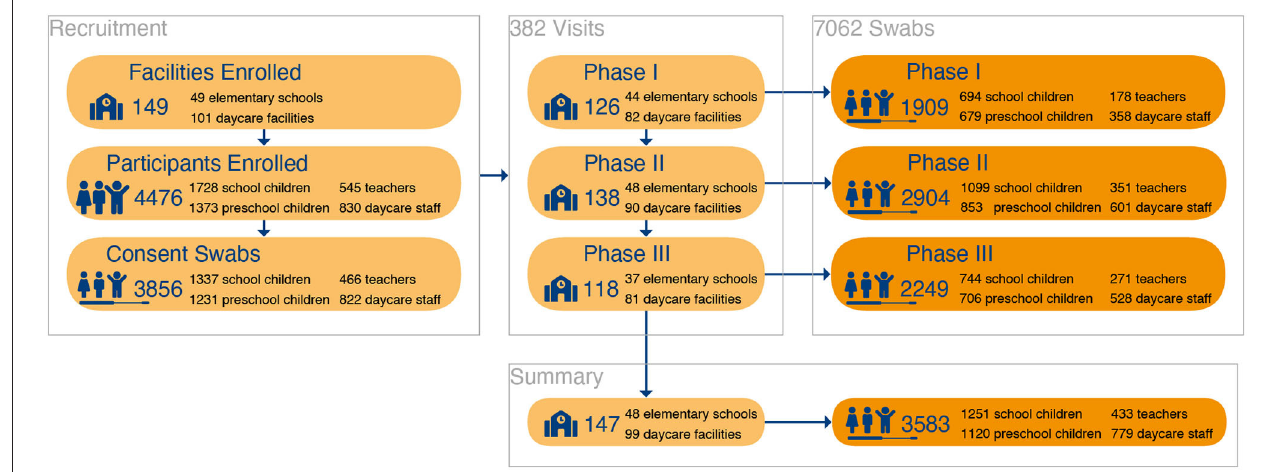
FIGURE 2 | Participant Flow: Inclusion and participation of study individuals for throat swab- PCR-testing.